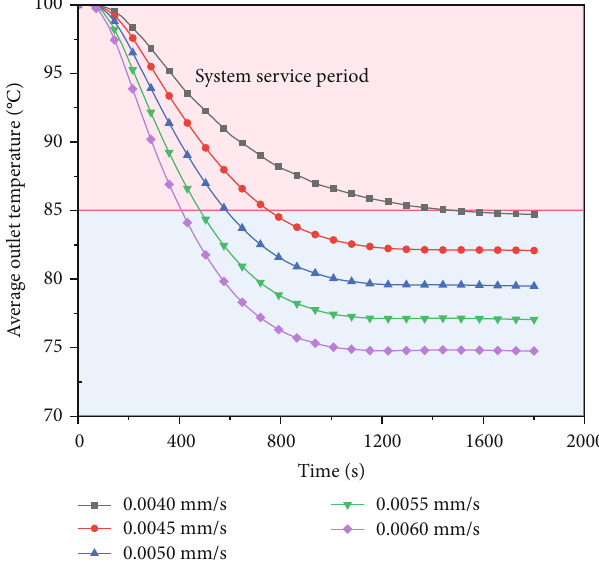
Figure 12: Variations of average outlet temperature at di ff erent fl uid injection velocities.